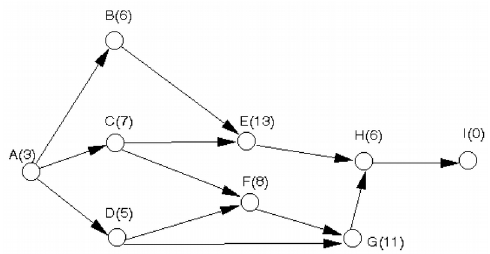
Figure 2. Example of the Activity on Node Diagram